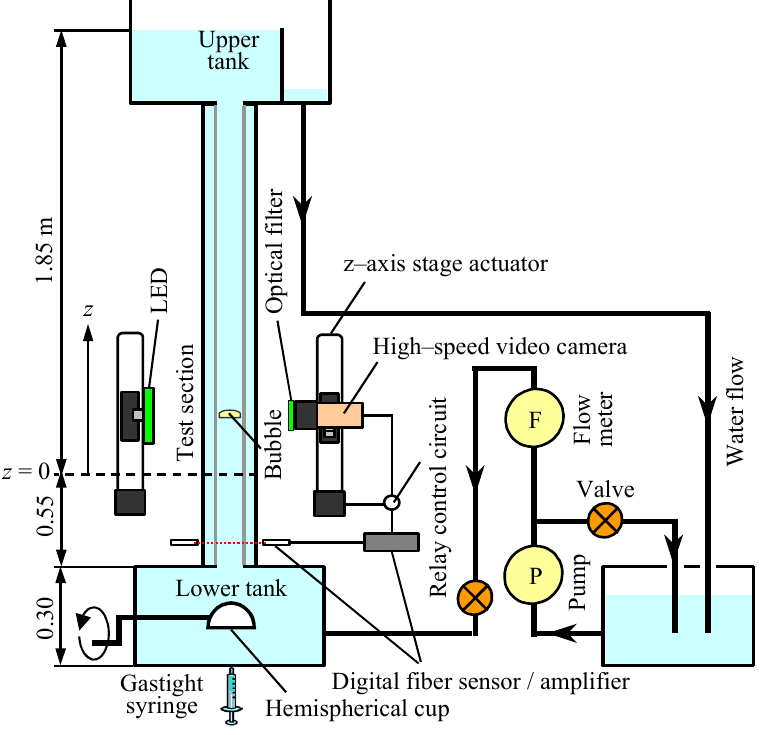
Fig. 1 Schematic of the experimental